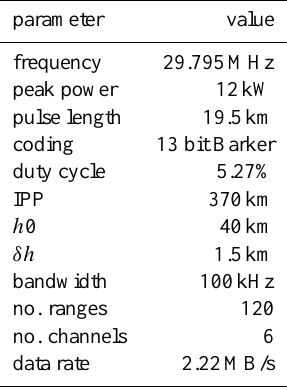
Table 1. Coherent scatter radar characteristics for the July/August, 2007